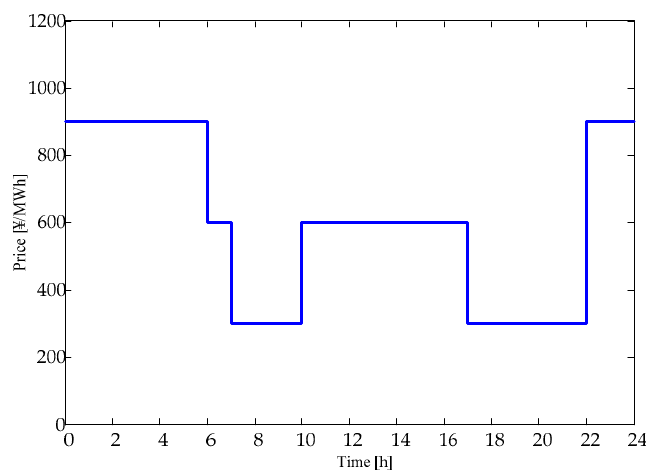
Figure 8. Price of electricity purchased by the distribution company.